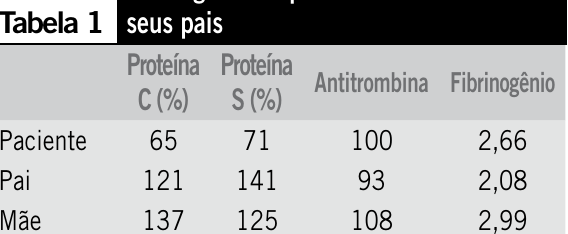
A pesquisa do FVL no paciente e nos seus genitores evidenciou resultados compatíveis com a presença do